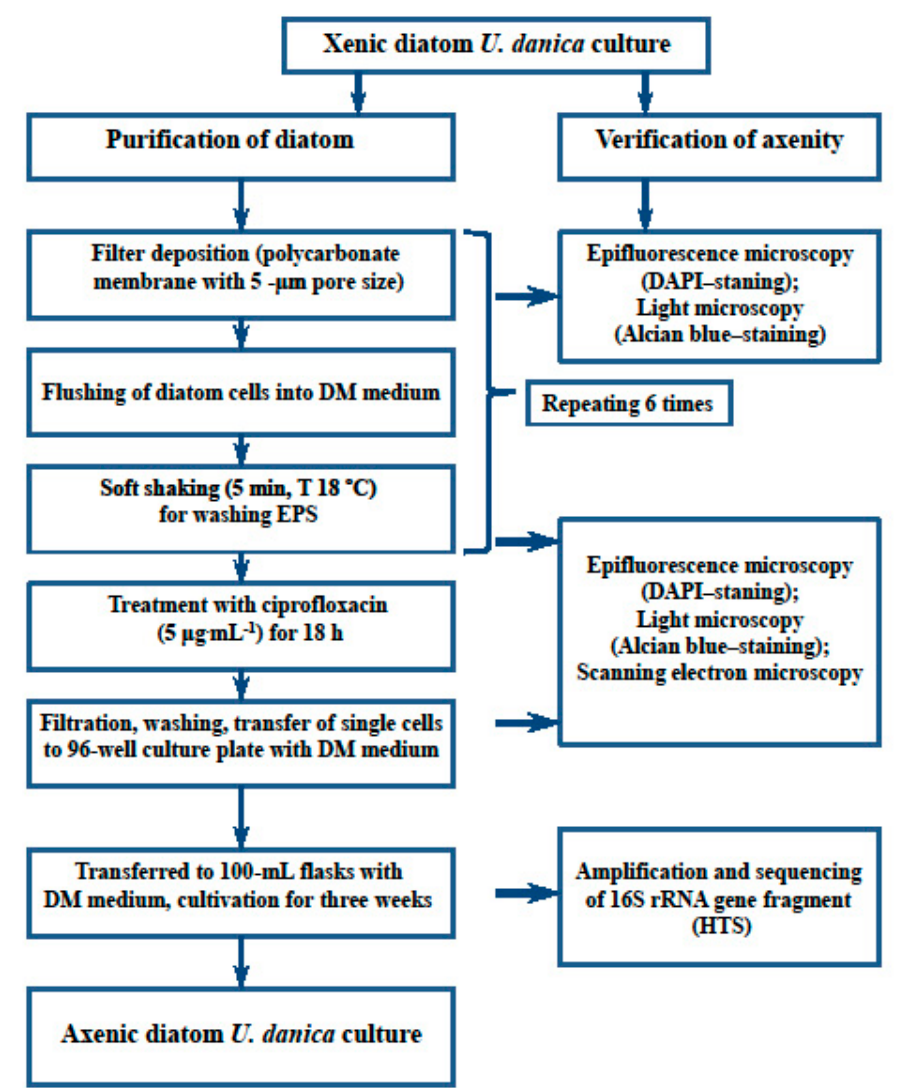
Figure 3. Main steps taken during the purification of the culture of planktonic diatom U. danica from Lake